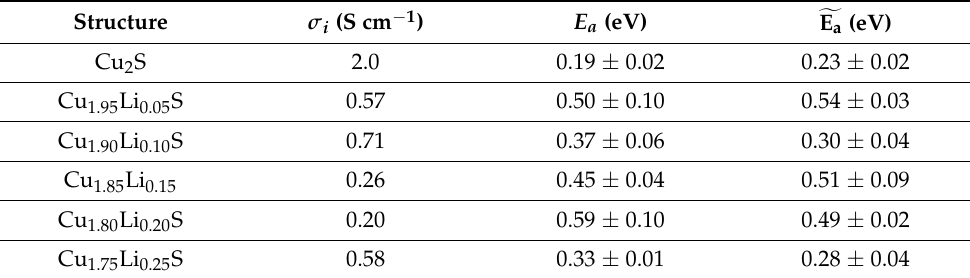
Table 1. Parameters of ion transport in solid solutions Li x Cu 2-x S near a temperature of 355 ◦ C. Reprinted from reference [24]. Copyright 2003 John Wiley and